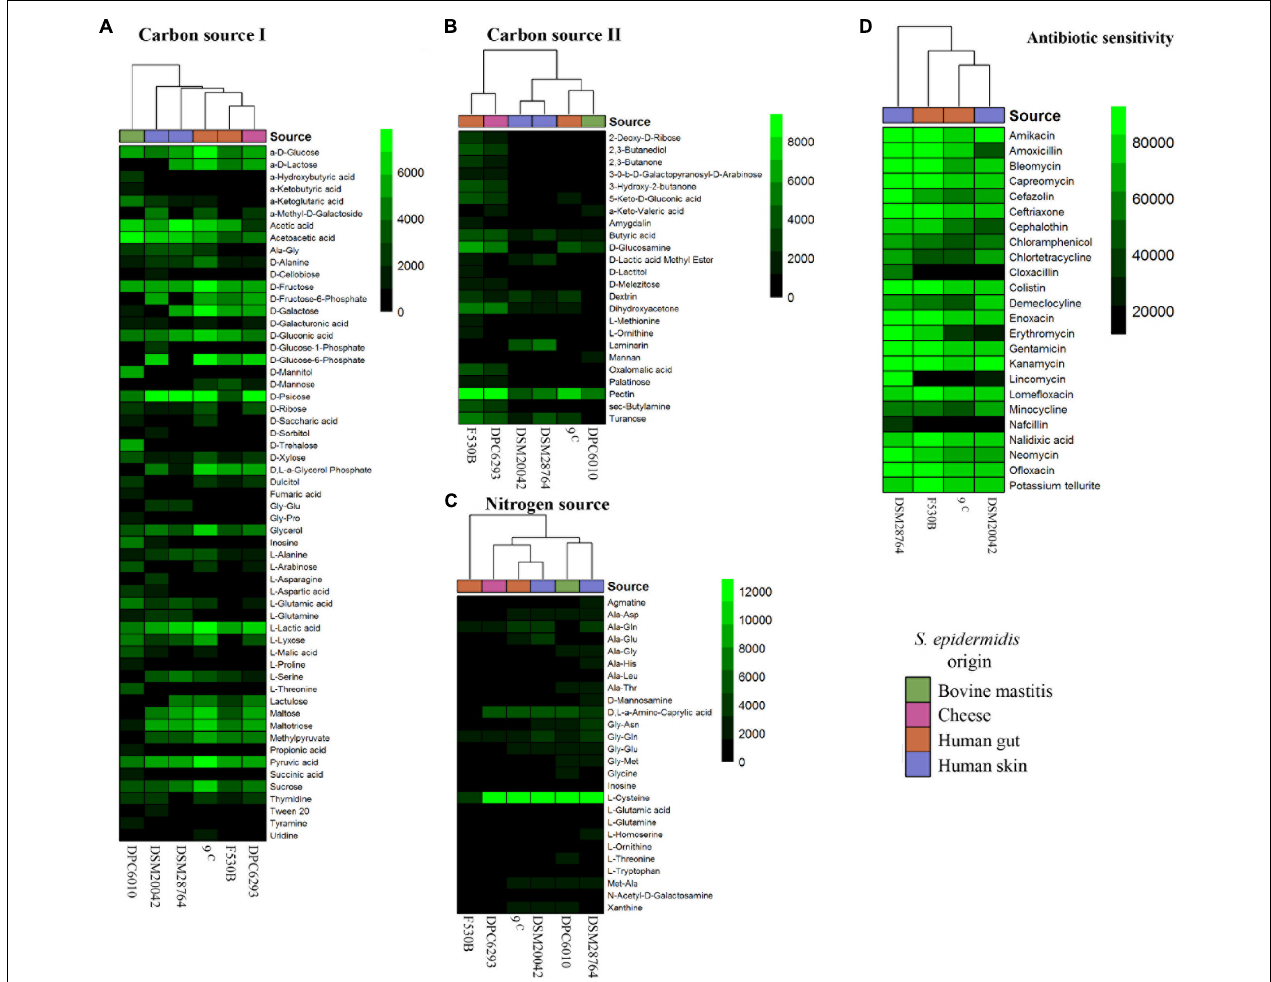
FIGURE 2 | Biolog results for growth of S. epidermidis stool (9 c and F530B), skin (DSM 20042 and DSM 28764), cheese (DPC6293), and mastitis (DPC6010) isolates. (A) Carbon sources (I) PM1; (B) Carbon sources (II) PM2A; (C) Nitrogen sources PM3B; and (D) Antibiotic PM11C. Colors in scales represent arbitrary units of growth based on Omnilog growth